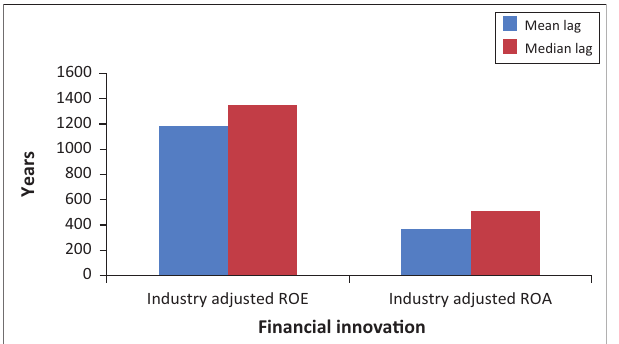
FIGURE 2: Firm financial performance speed of adjustment to financial innovation.